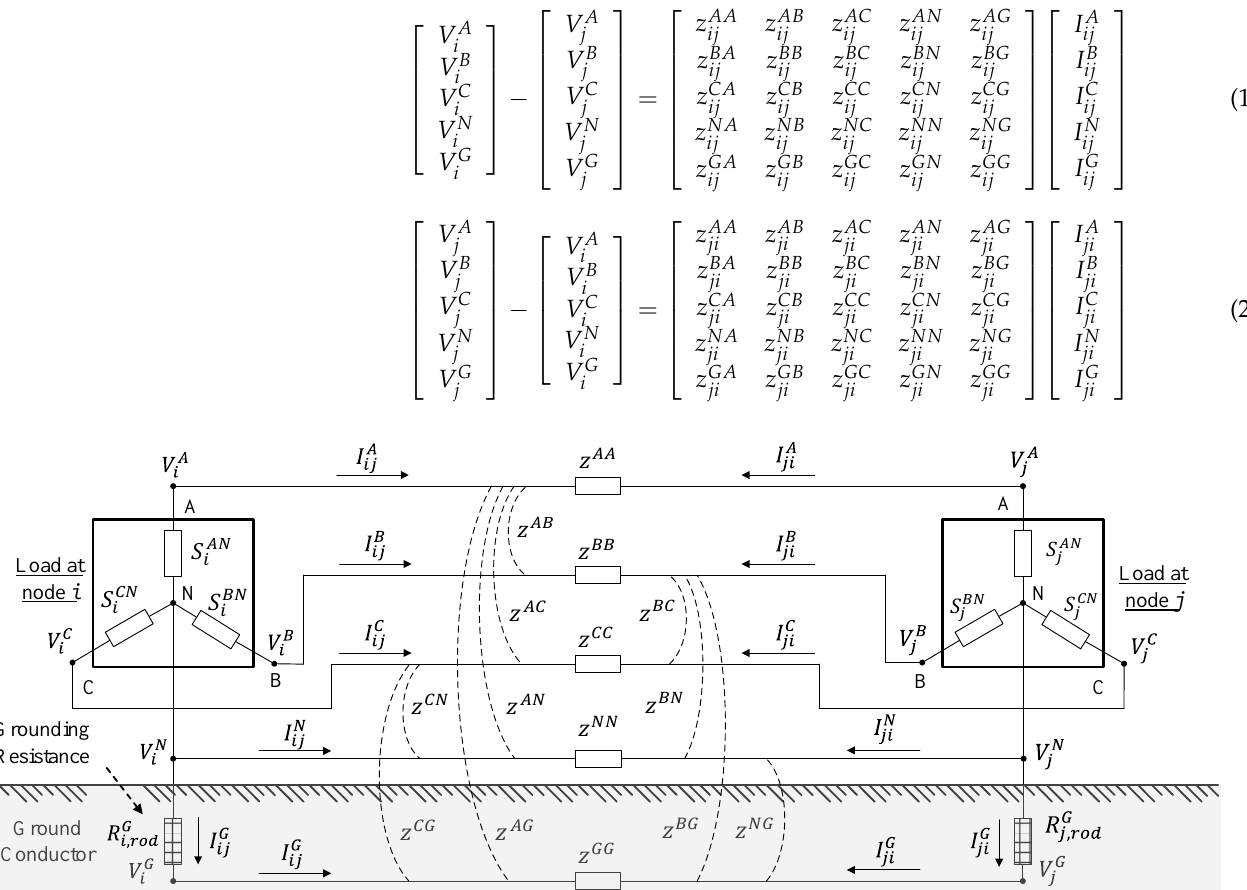
Figure 1. The original branch model.